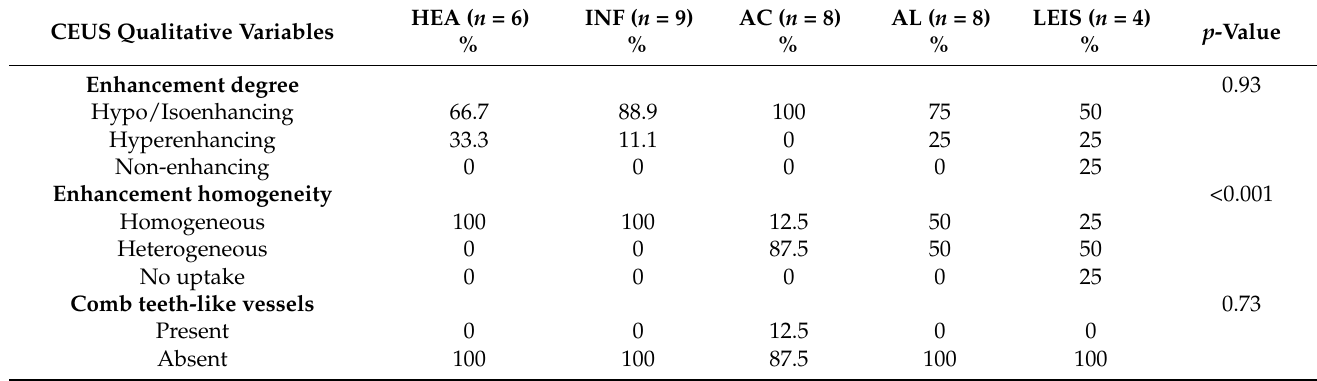
Table 4. Qualitative parameters reported as mean values of CEUS examination for healthy (HEA), inflammatory (INF), adenocarcinoma (AC), lymphoma (AL), and leiomyosarcoma (LEIS). CEUS Qualitative